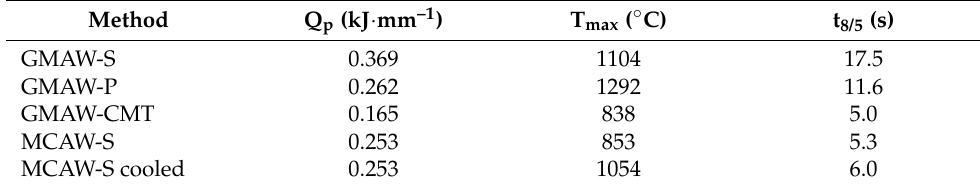
Table 5. Values of the thermal cycles analysis.